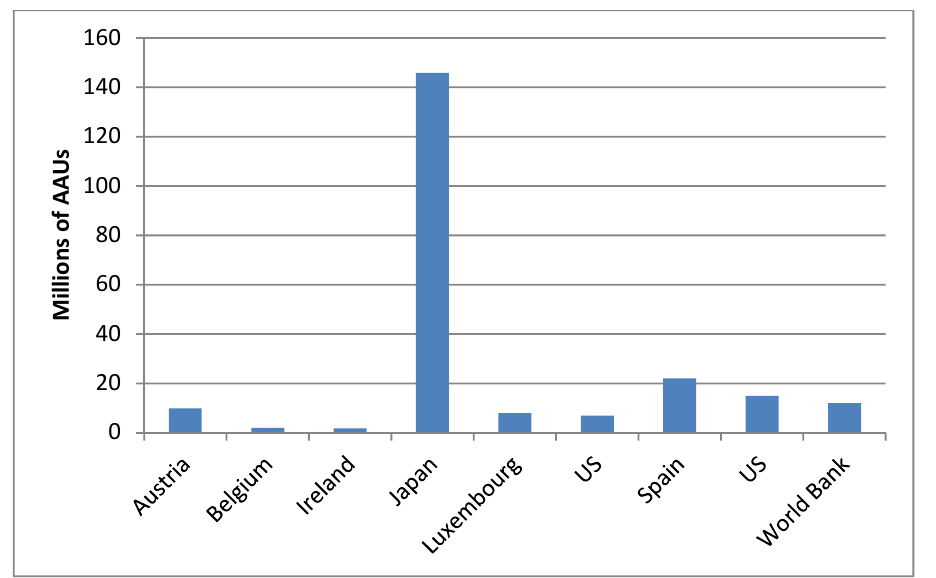
Figure 2. Assigned amount unit (AAU) Purchases